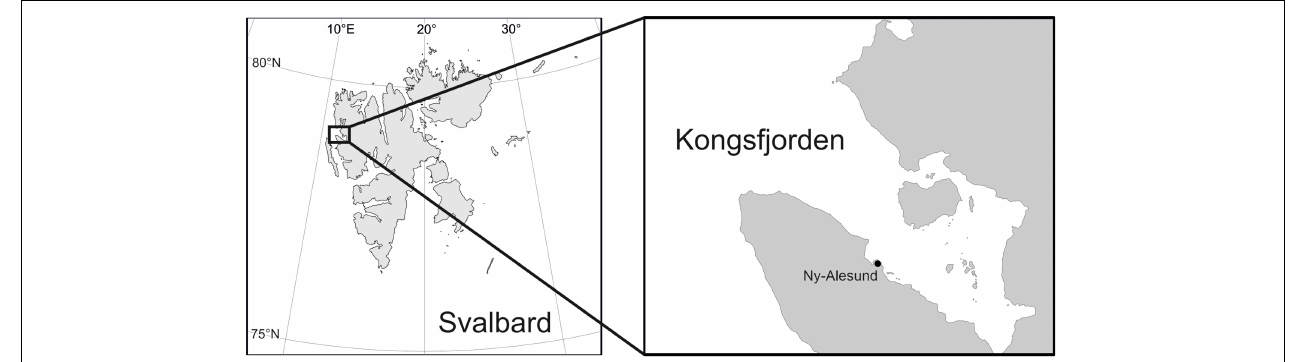
FIGURE 1 | Map of the study area.